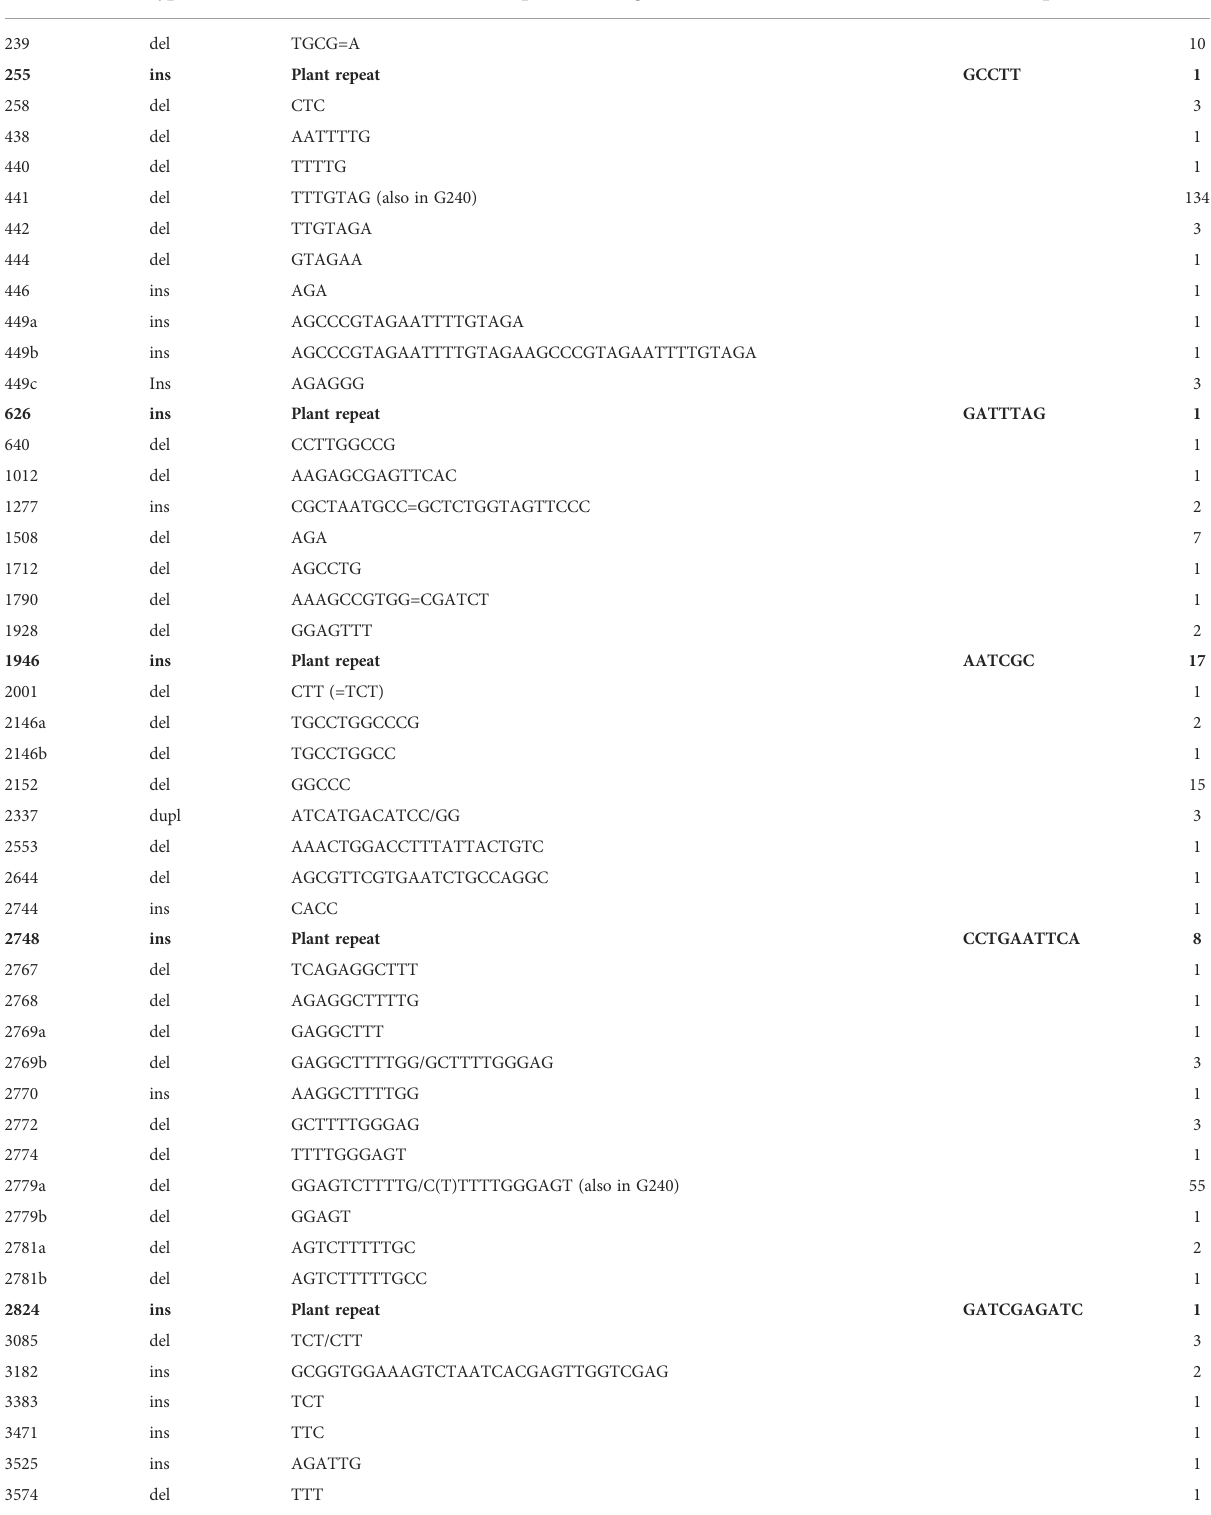
TABLE 1 Summary of indels in different CaTA